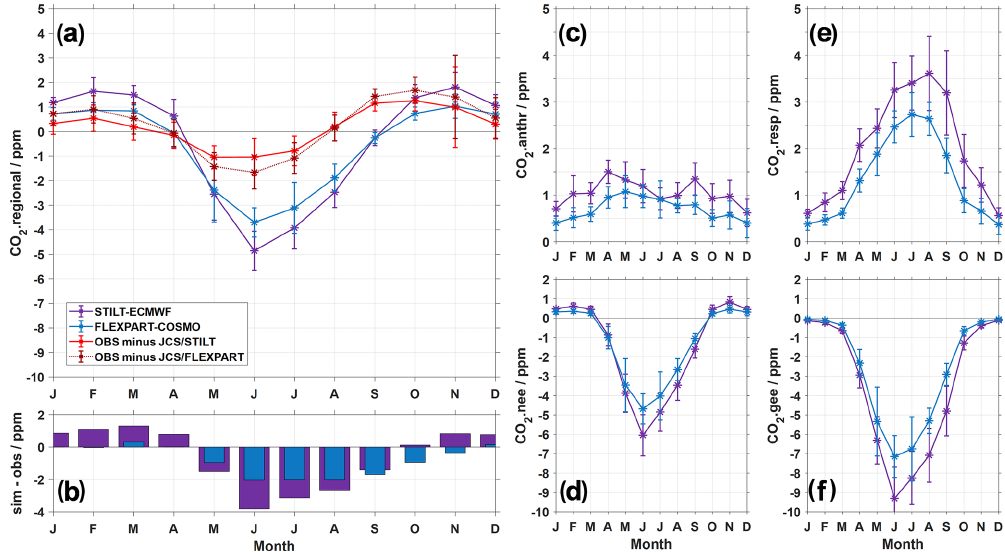
Figure 1. Multi-annual monthly means of 3-hourly regional CO 2 simulations compared to observations (2009–2017). CO 2 .regional (a) , its components CO 2 .anthr (c) , and net ecosystem exchange (CO 2 .nee) (d) . The difference between simulations (sim) and observations (obs) is presented in (b) . CO 2 .nee is composed of (e) gross ecosystem respiration (CO 2 .resp) and (f) gross ecosystem exchange (CO 2 .gee), i.e. gross uptake. Error bars represent 1SD of the multi-annual means and reflect the year-to-year variability for